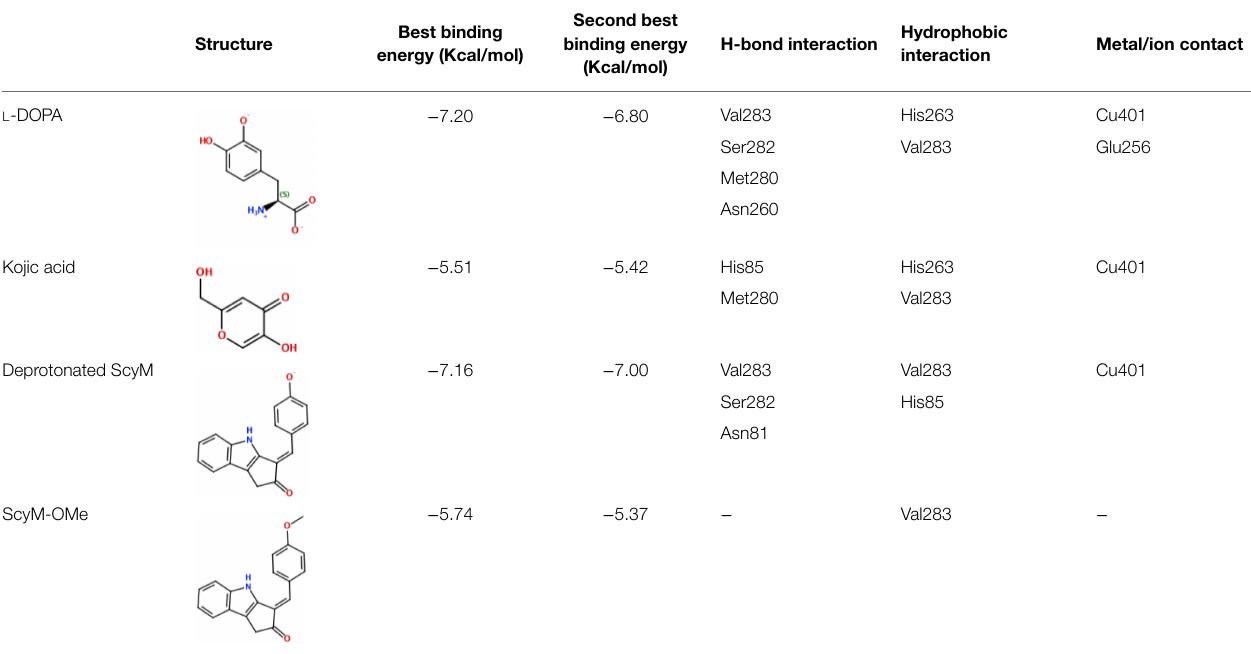
TABLE 4 | Results from docking assays of various inhibitors and substrates with mushroom tyrosinase, including binding energies and common ligand interactions with the binding pocket residues.